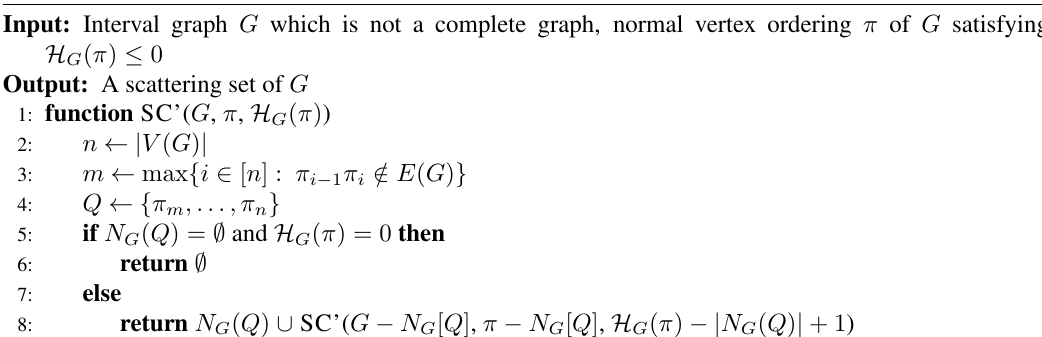
Algorithm 3.3 A scattering set of an interval graph with nonpositive Hamiltonian